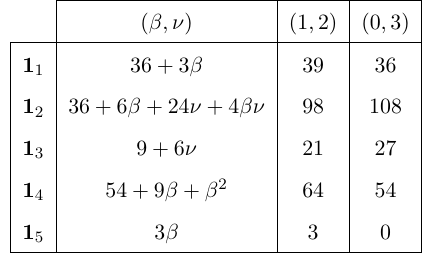
Table 9 . Hypermultiplet multiplicities for the charged matter in the two explicit charge 5 models constructed in the double cover K 3 over P 2